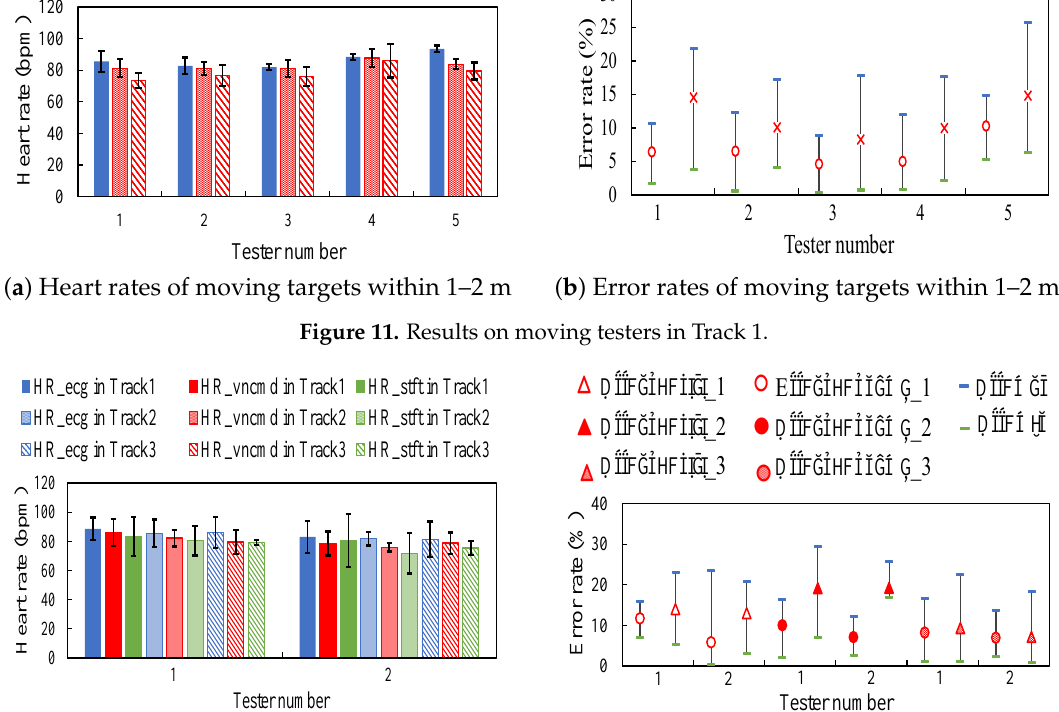
Figure 12. Results on moving testers in Tracks 1–3.